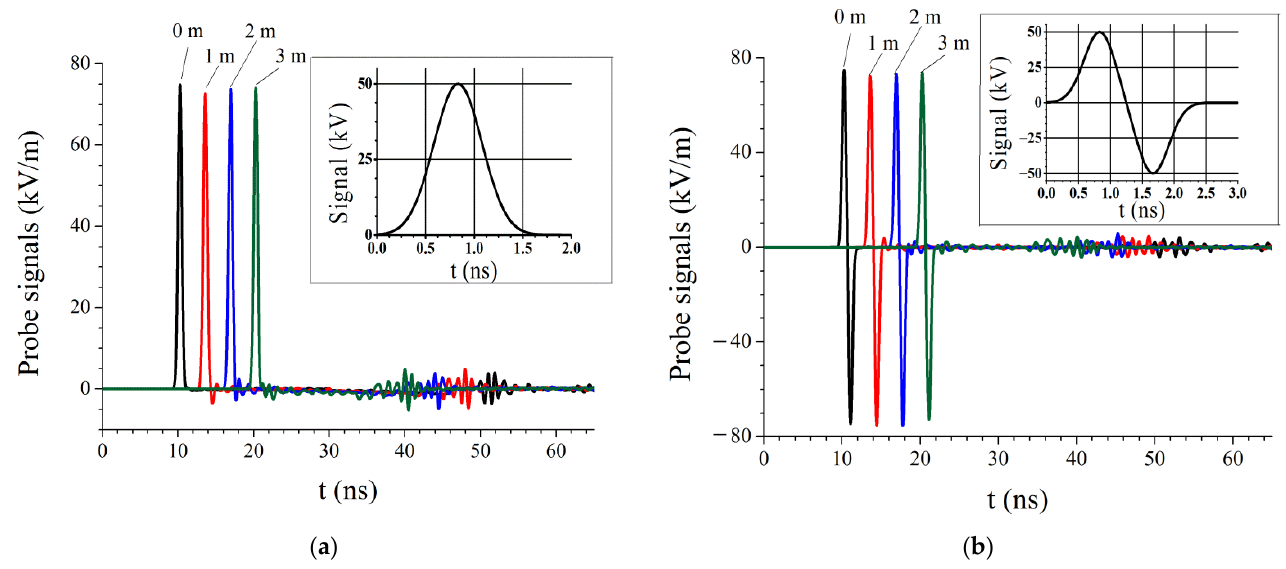
Figure 3. Radial component of the EMP electric field calculated at the following distances z from the start of the uniform section of the line: 0 m, 1 m, 2 m, and 3 m. The distance from the axis of the line is r = 30 cm. ( a ) Unipolar pulse and ( b ) bipolar pulse.